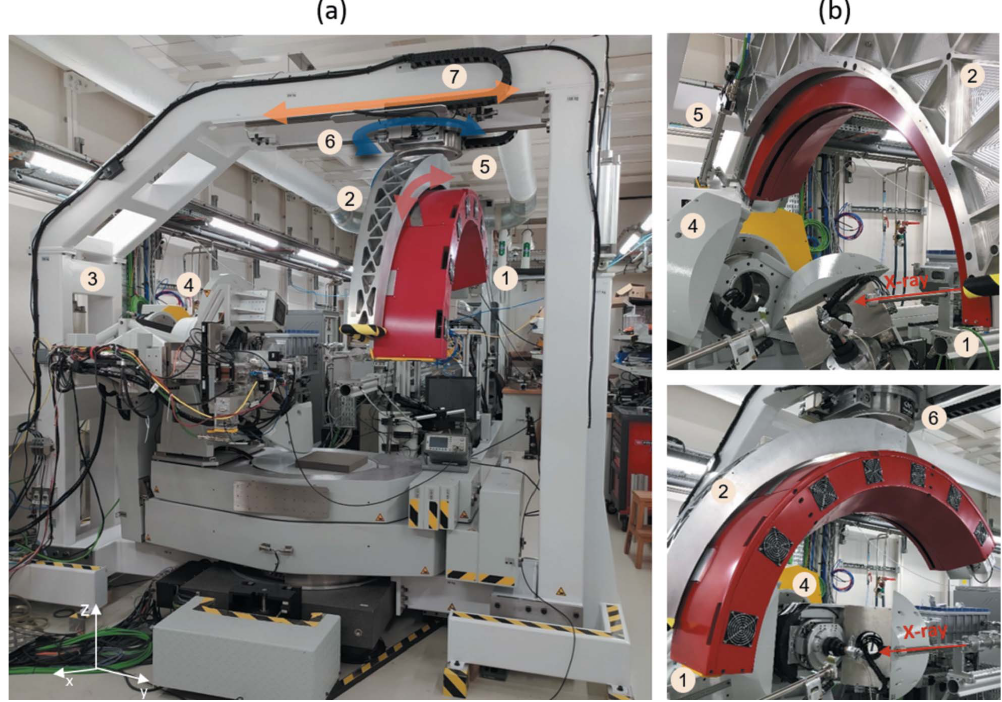
Figure 6 ( a ) The CirPAD installed on the diffractometer on the DiffAbs beamline at SOLEIL, showing ( 1 ) CirPAD, ( 2 ) arch, ( 3 ) crane, ( 4 ) diffractometer, ( 5 ) motorized rotation (16.5 (cid:3) amplitude, around the y axis), ( 6 ) motorized rotation (120 (cid:3) amplitude, around the z axis) and ( 7 ) manual translation. ( b ) The CirPAD in the two different working positions, with an angle of 90 or 0 (cid:3) between its detection plane and the direction of the incident beam.